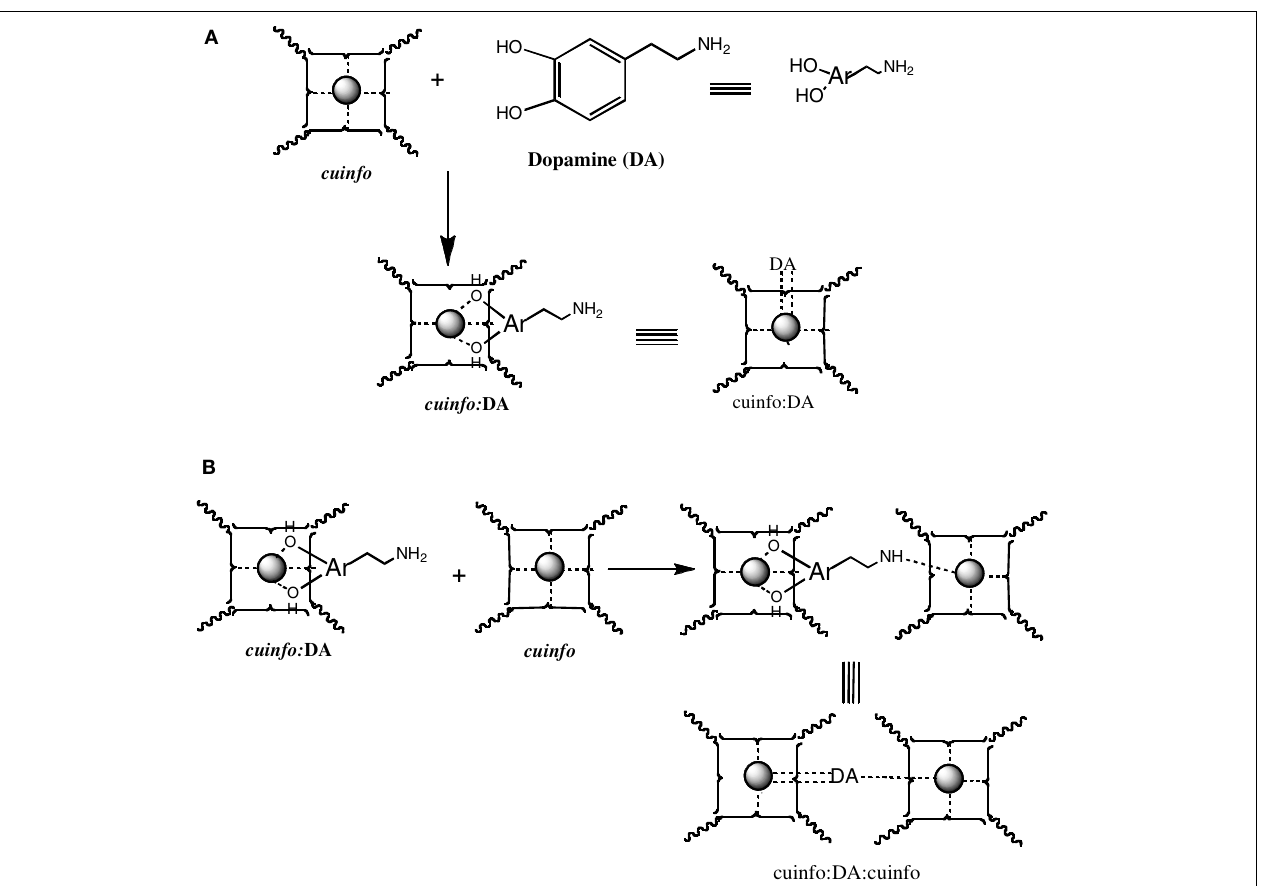
FIGURE 5 | Formation of mixed dopamine: cuinfo complexes. (A) Formation of ternary cuinfo complex with one catecholamine. (B) Formation of a entangled dopamine (DA) complex (cuinfo 2 :DA).